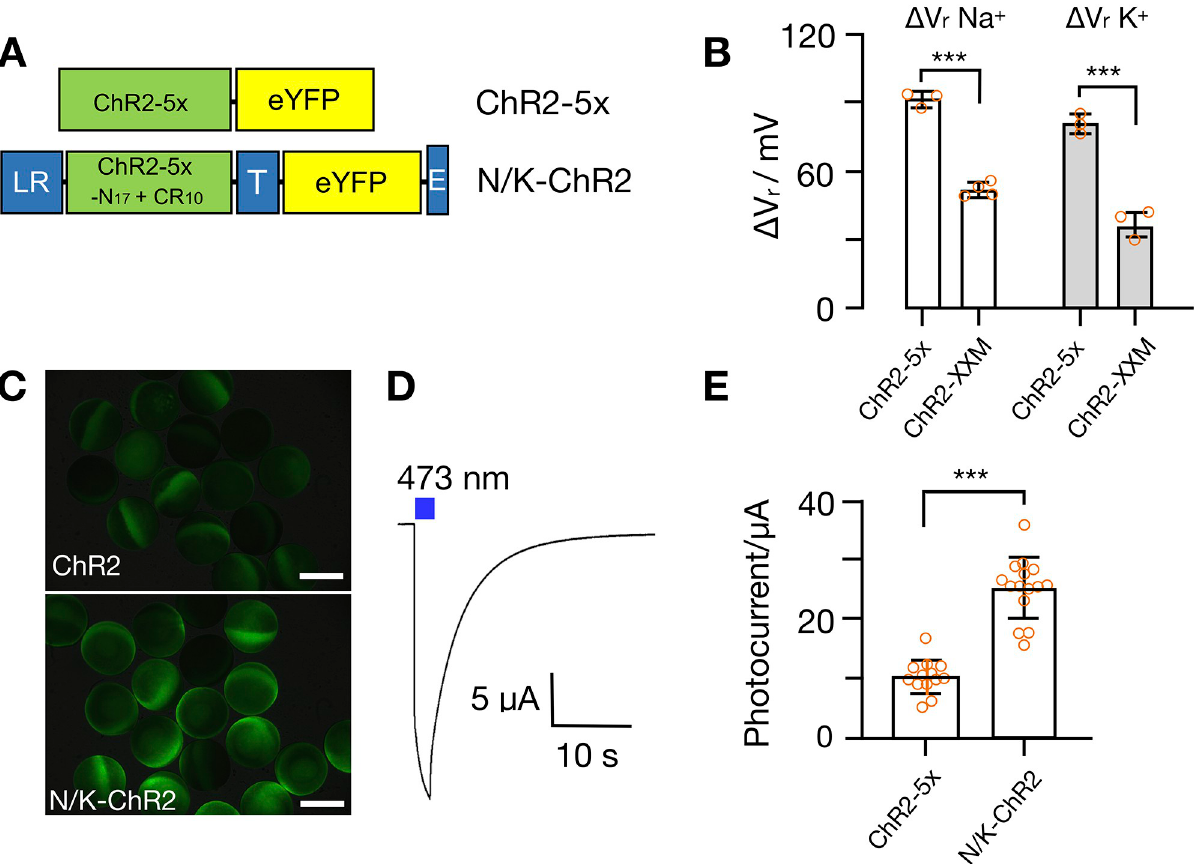
Fig 4. Engineering of N/K-ChR2. (A) Schemes of ChR2-5x and N/K-ChR2. ChR2-5x is a ChR2 variant with 5 point mutations. N/K-ChR2 comprises ChR2-5x scaffold with CR 10 (= first 10 amino acids from proton pump rhodopsin CsR) and N 17 (= first 17 amino acids from ChR2). The construct contains additional domains in N- and C-terminus namely LR domain (= N-terminal signal peptide Lucy-Rho), T domain (= the plasma membrane trafficking signal from Kir2.1) and E domain (= the endoplasmic reticulum (ER) export signal from Kir2.1). (B) Shift in reversal potential ( Δ V r ) recorded in Xenopus ooccytes expressing either ChR2-5x or ChR2-XXM upon changing extracellular solution from 1 mM to 120 mM NaCl ( Δ V r Na + ) or KCl ( Δ V r K + ). Values represent mean ± SD, n = 3–4. (C) Images of Xenopus oocytes expressing ChR2-5X and N/K-ChR2; scale bar = 1 mm. (D) Representative photocurrent trace from N/K-ChR2 expressing oocyte elicited by illumination with blue light (472 nm, blue bar); oocyte incubated in solution containing (in mM) 110 NaCl, 5 KCl, 2 BaCl 2 , 1 MgCl 2 , 5 HEPES/ pH 7.6). Holding potential at -70 mV. (E) Mean photocurrent amplitudes of ChR2-5x and N/K-ChR2 recorded as in C ; n = 13–15. P value of statistical significance in B and E from unpaired t-test indicated as *** = P < 0.001.